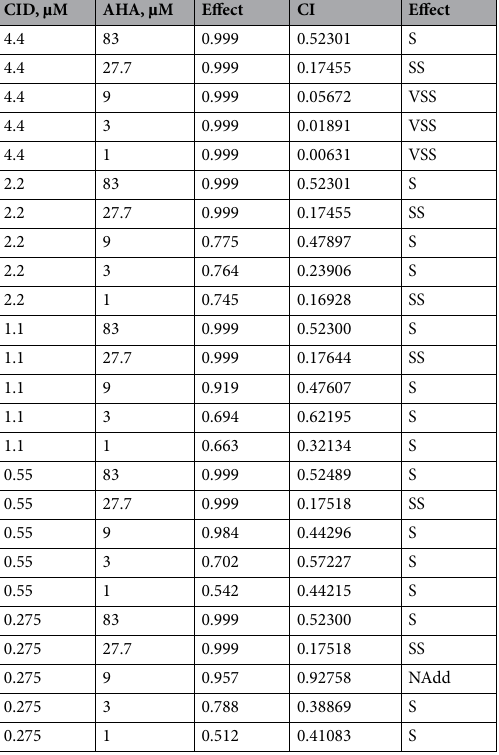
Table 2. Combination Index Summary for CID 3117694 and AHA. CI–Combination Index, S–synergism, SS- strong synergism, VSS–very strong synergism, NAdd–nearly additive. See Table in the Materials and Methods for the determination of synergy ranges and CI